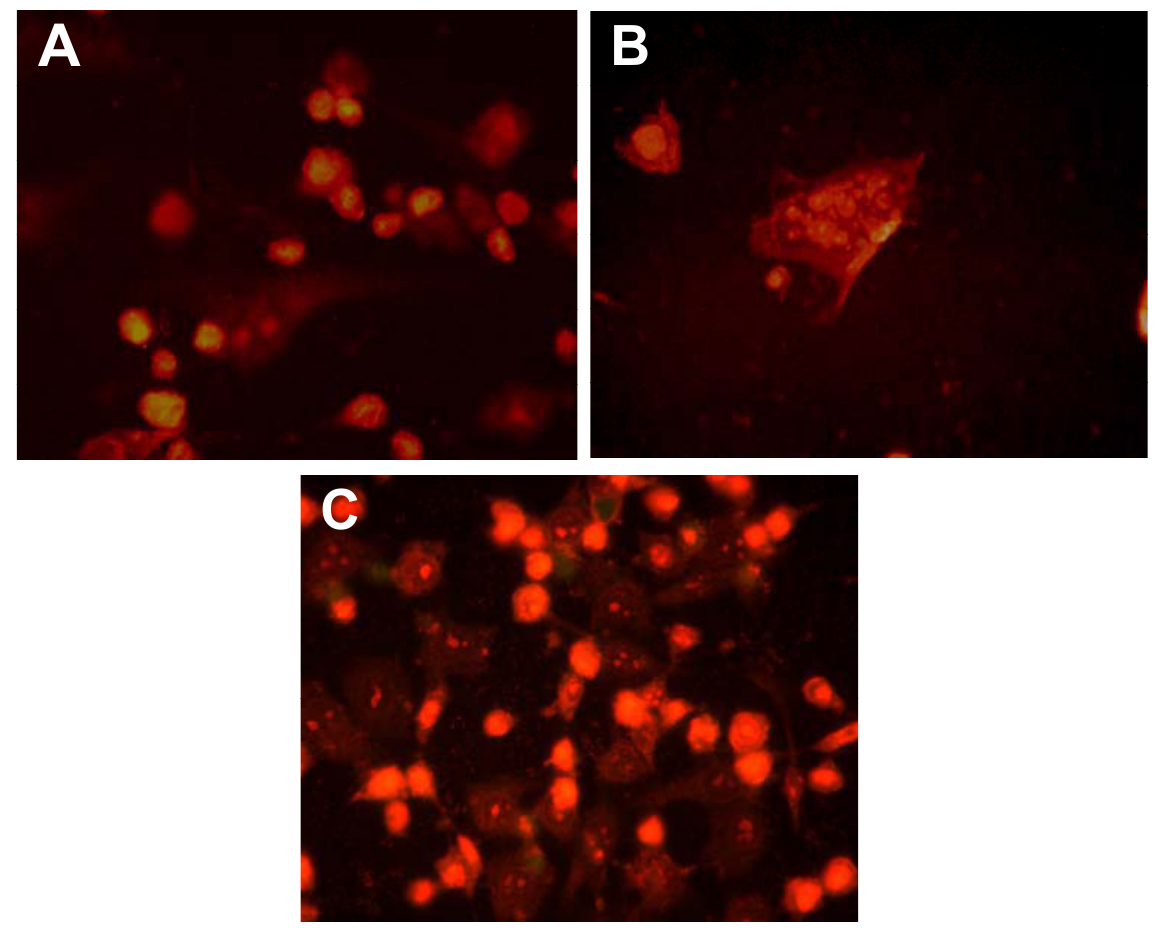
Fig. 5 Specific effects of poliovirus (A); echovirus (B); Coxsackie virus B4 (C), on TV cells (PI ×